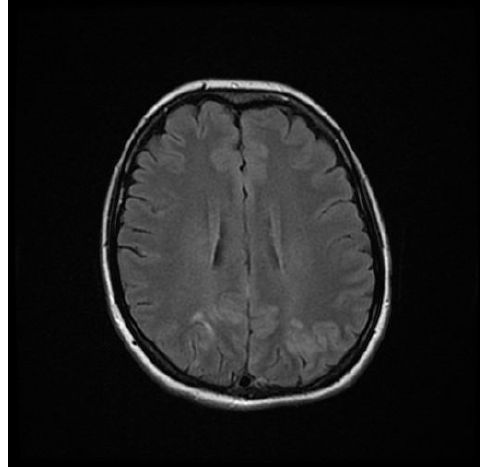
Figure 2. FLAIR MRI sequence of the brain.